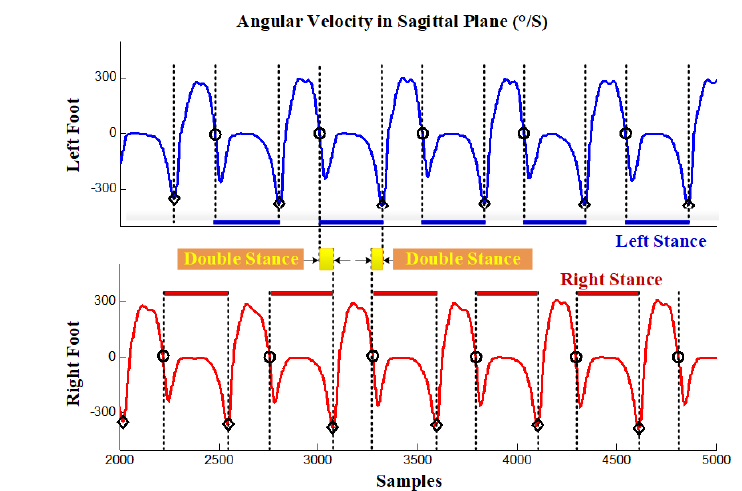
Figure 8. Gait phase detection using angular velocity in the sagittal plane: Single stance phase and double stance